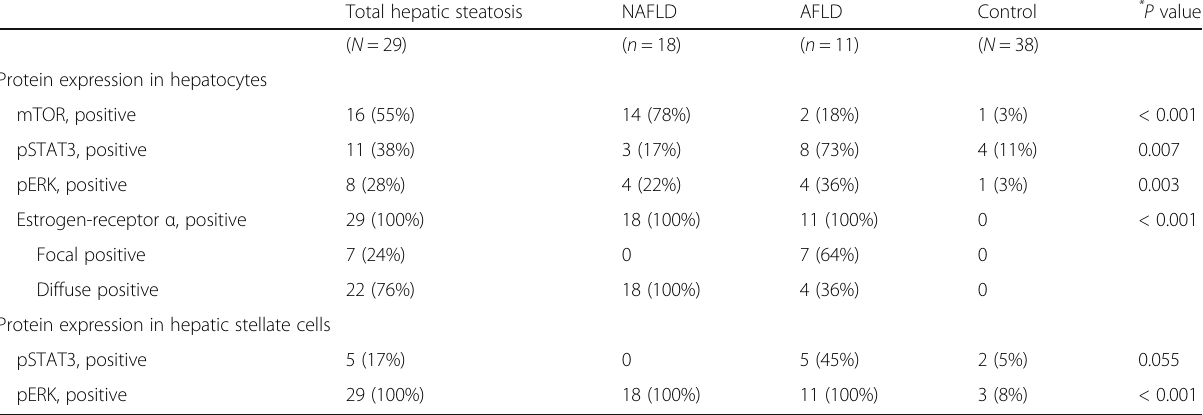
Table 2 Comparison of protein expression features in hepatic steatosis patients and the control group Total hepatic